Question: Write the caption for this figure.
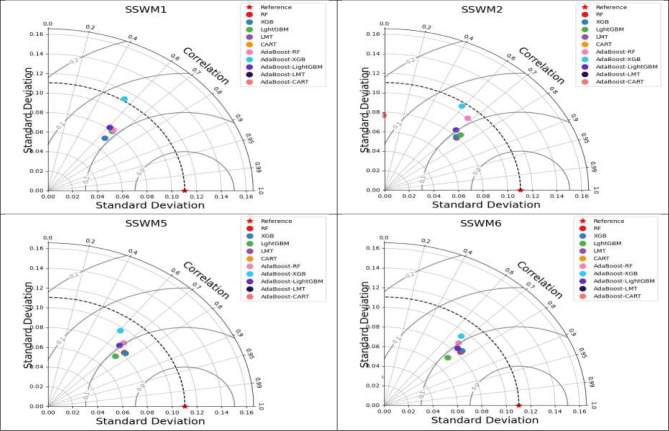
Answer: Taylor diagram showing the relationship of correlation coefficient between actual and predicted SSW of the Moga region during testing of the models.